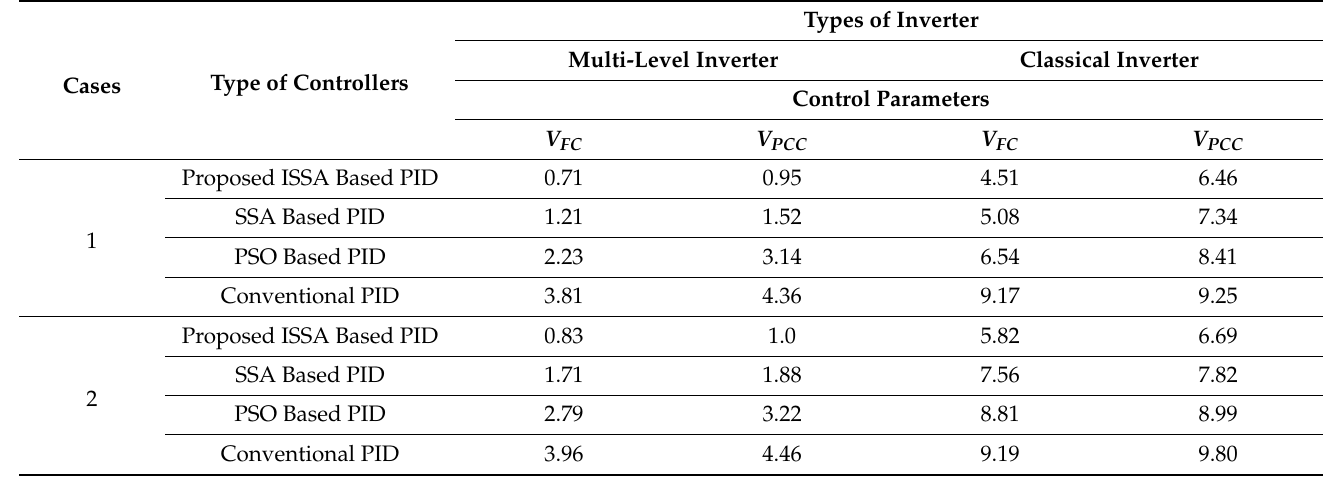
Table 1. THD Values of the System under Different Controllers.